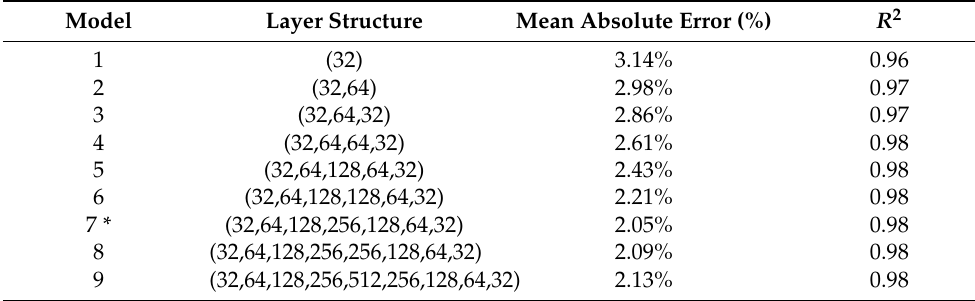
Table 4. Hyperparameter tuning for the layer structure.